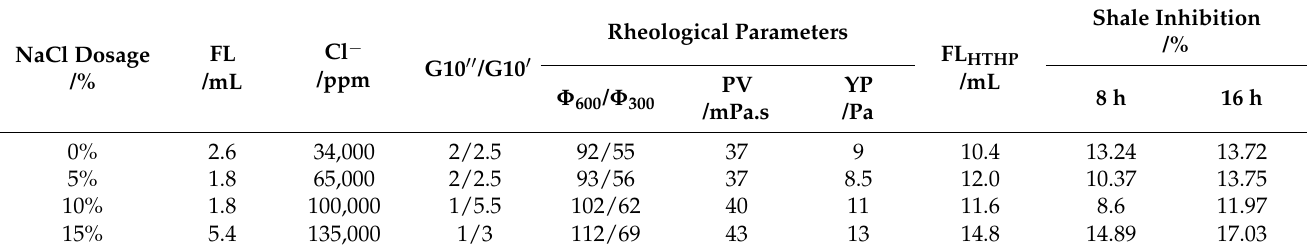
Table 4. Evaluation of salt resistance of polyamine potassium chloride